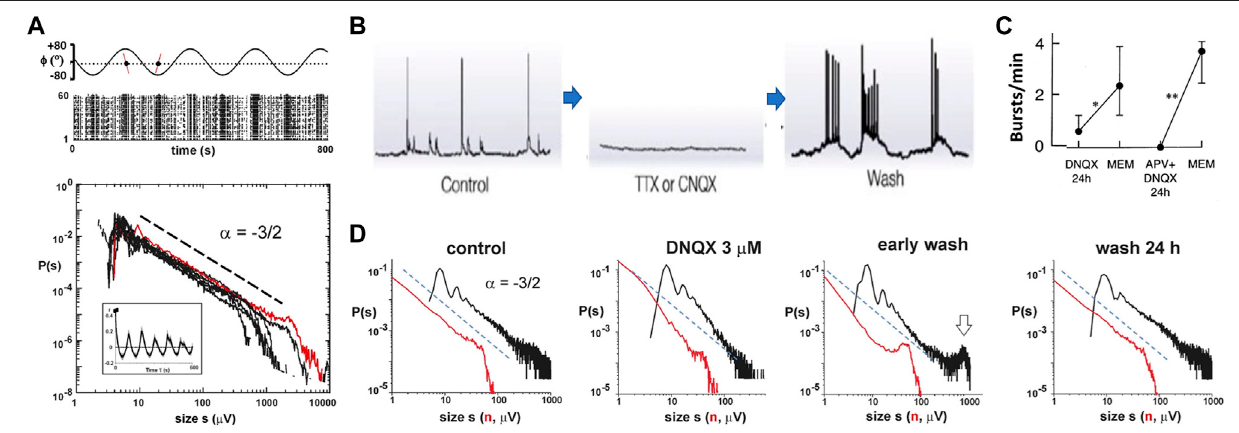
FIGURE 9 | Separation of time scales and homeostatic regulation of neuronal avalanches in vitro . (A) Power law in avalanche sizes is preserved during externally induced slow changes in neuronal activity. Top : periodic tilting ( ϕ ) of the sealed, sterile chamber, which contains the organotypic culture grown on the MEA, alternates cultureexposuretofeedingmediumorair.ThisslowlydrivesthenetworkthroughthecorrespondinglargechangesinnLFPactivityvisualizedinthecorrespondingraster plot. Bottom : power law in avalanche sizes for n (cid:2) 7 cultures under conditions of periodic tilting. Red : distribution from single culture shown in the raster plot. Inset : average autocorrelation of population activity demonstrating strong correlations from periodic tilting. (B) Intracellular recording demonstrating rebound hyperactivity when neuronal activity is suppressed in dissociated cortex cultures (reproduced with permission from [101]). (C) Increase in rebound population bursts after 24 h of excitatory glutamate receptor suppression in organotypic cortex cultures (reproduced with permission from [100]). (D) Homeostatic regulation of avalanches in organotypic cortex cultures. Control : size distribution before manipulation. DNQX : size distribution during 24 h of reducing excitatory synaptic transmission. Early wash : bimodal size distribution demonstrating hyperexcitability after wash out of DNQX. Wash 24 h: homeostatic return to avalanche dynamics before pharmacological manipulation. Distributions are based on 1 h recordings each from a single culture ( A , D reproduced with permission from [11]).